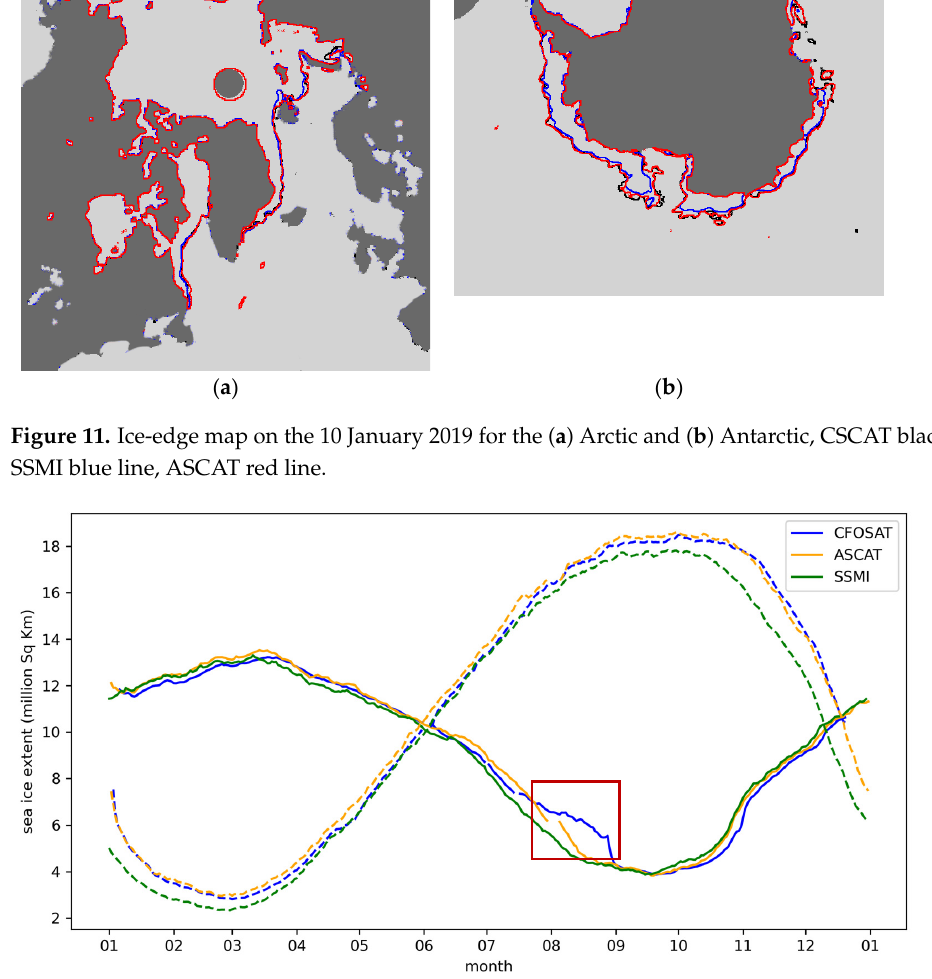
Figure 12. Daily Arctic (solid lines) and Antarctic (dashed lines) sea ice extents in 2019 from CFOSAT (blue), ASCAT (orange), and SSMI (green); the red rectangular area marks the period when CSCAT instrument restarted. Table 1. Sea ice extent year-long average difference between ASCAT and all_inc, truncated_inc and